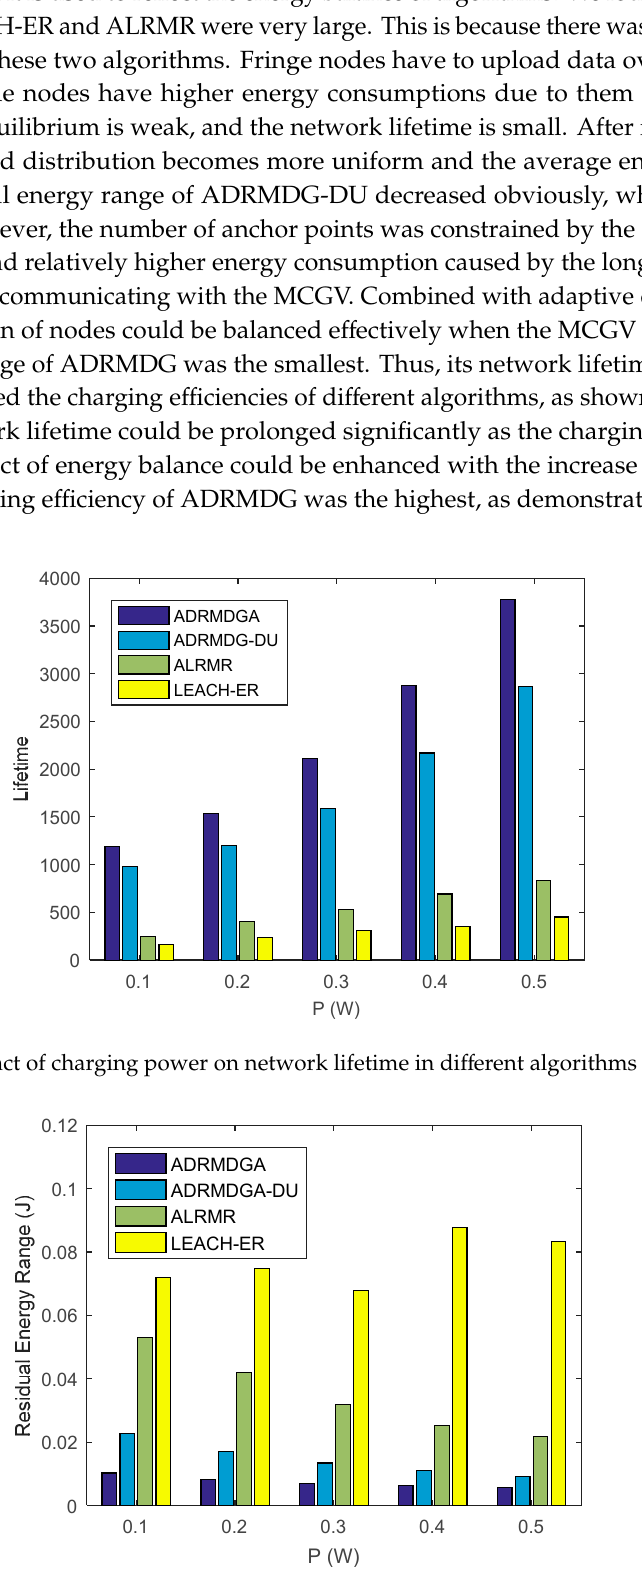
Figure 9. Impact of charging power on residual energy range in different algorithms ( N = 100).